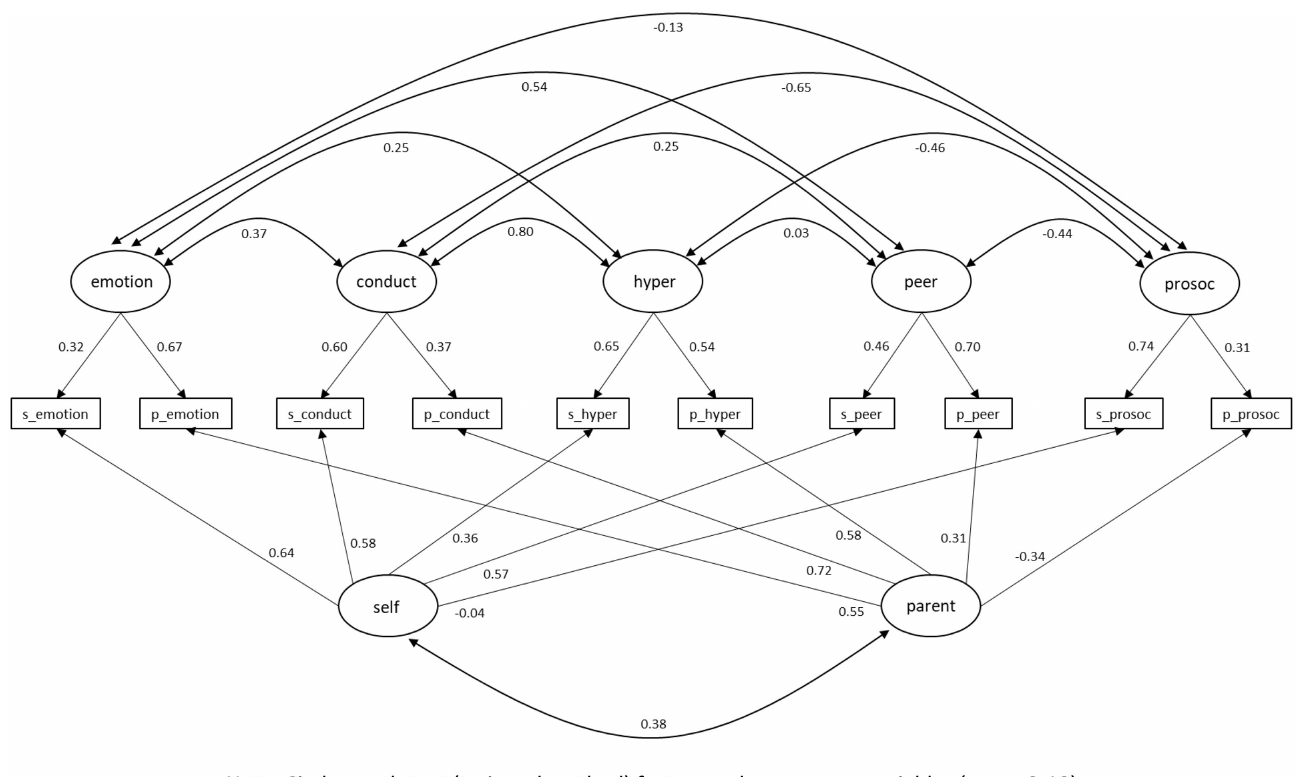
Fig 3. Structural MTMM model of the SDQ for Chilean adolescents (n = 1,284) using CFA.